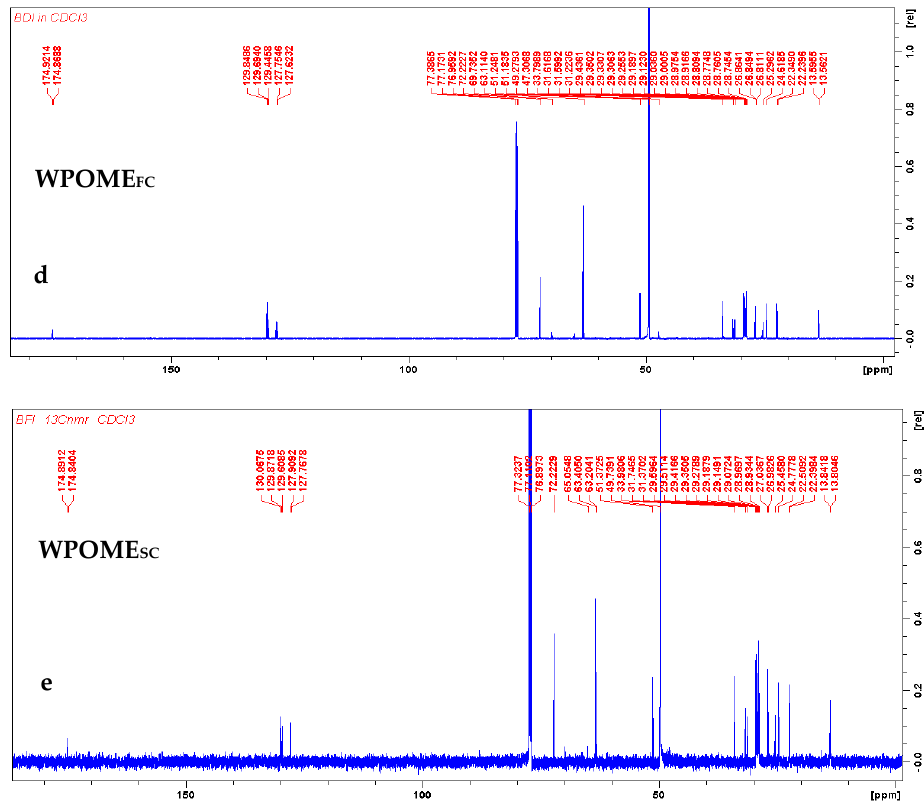
Figure 5. 13 C NMR spectra for NPO, WPO and WPOME samples.